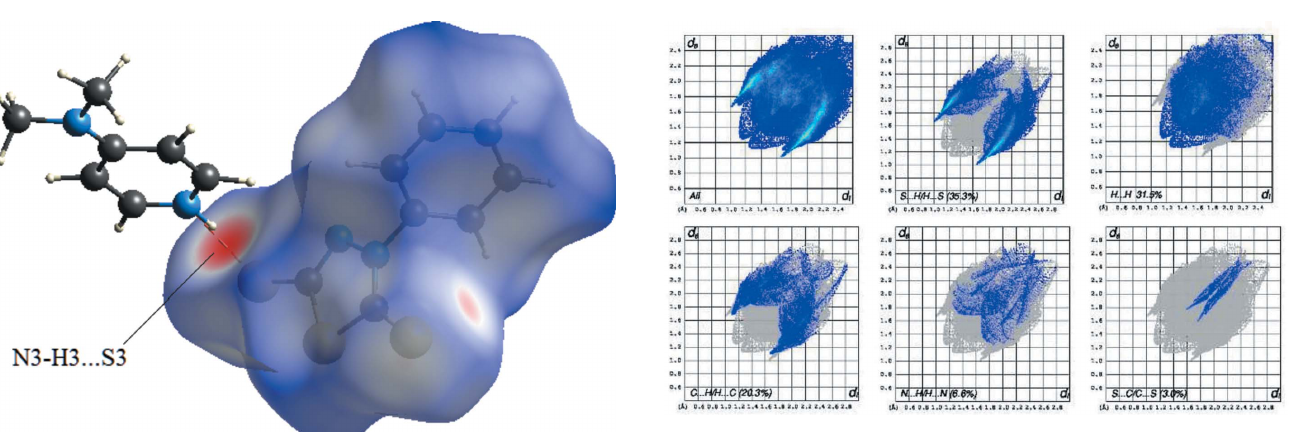
Figure 9 The two-dimensional fingerprint plots for compound (II). The d i and d e values are the closest internal and external distances (in A˚ ) from a given point on the Hirshfeld surface depicted in Fig. 7.